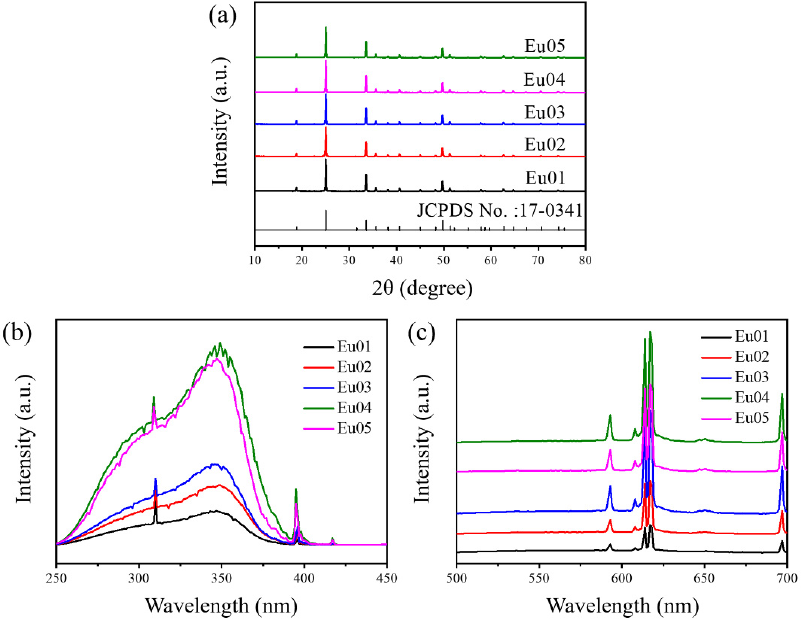
Figure 3. ( a ) XRD patterns of YVO 4 :Bi,Eu. ( b ) Excitation ( λ em = 618 nm) spectra of YVO 4 :Bi,Eu. ( c ) Emission ( λ ex = 365 nm) spectra of YVO 4